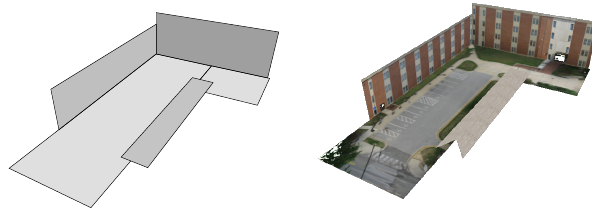
Fig. 6. Example of a planar patch scene model